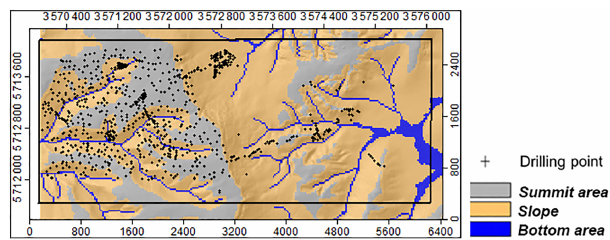
Figure 12. Drilling points from LBEG soil profile database on the units of the simplified geomorphographical map within the valida- tion rectangle.